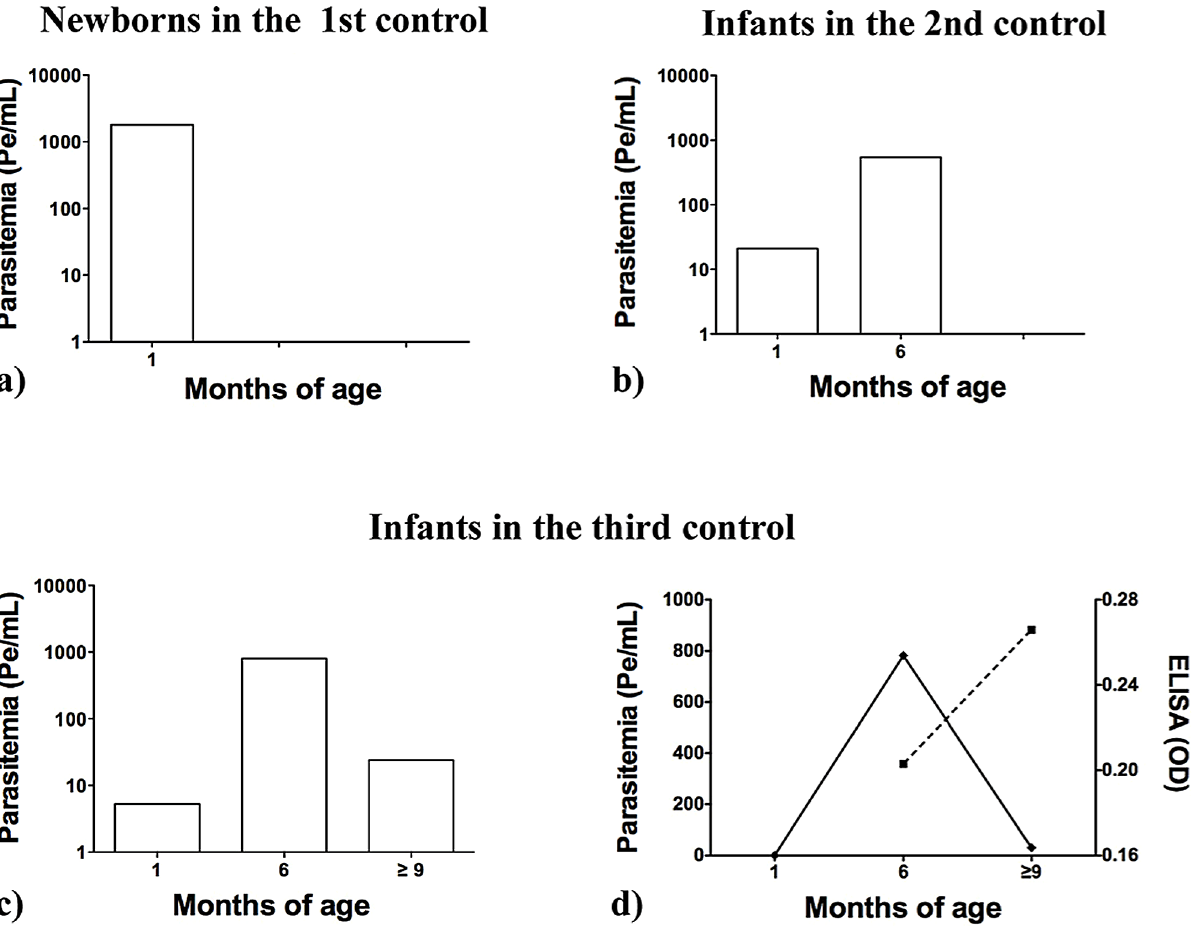
Figure 3. T.cruzi bloodstream parasite burden in infants followed-up during their first year of life. Parasitemia was quantified by qPCR in infants from group A (diagnosed at 1 month of age) (Fig. 3a); from group B (diagnosed at 6 months after delivery) (Fig. 3b); and from group C (diagnosed at around 1 year old (Fig 3c), as explained in Material and Methods. Fig. 3d shows a correlation of the parasitemia of Fig. 3c with the increment of ELISA antibodies titers (dashed line), tested at 6 and after 9 months of age.